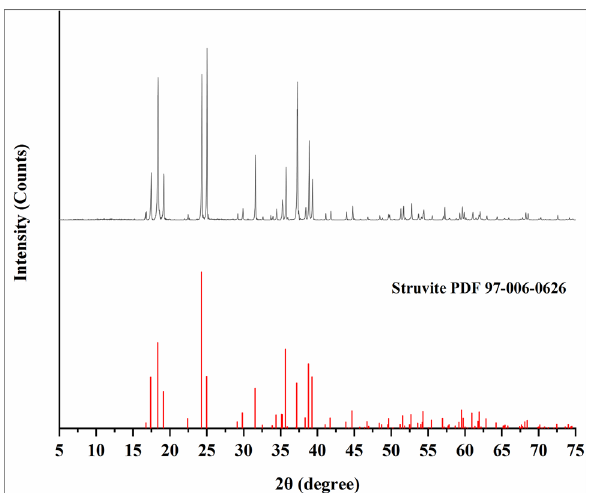
Figure 4. XRD analysis of the solid precipitate at an alkalinity of 3000 mg/L as CaCO 3 (initial pH = 7.9, Mg/P molar ratio = 1.5, [PO 4 –P] = 250 mg/L, [NH 4 –N] = 1000 mg/L, lignin = 0